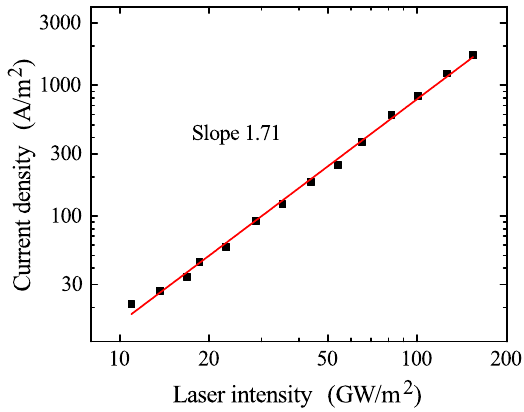
FIG. 4. Current density as a function of laser intensity for 310 nm (4.00 eV) in the log-log scale. These data are well fitted by a straight line with a slope of 1.71.